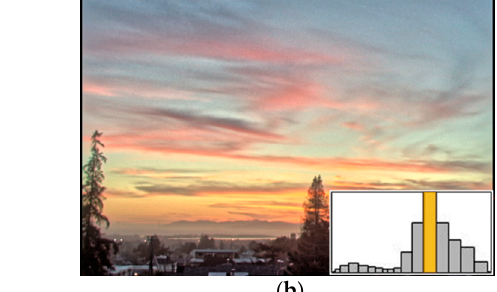
Figure 6. Self-evaluation of the proposed HVS-based modified histogram equalization. ( a ) Result and the histogram before correction, whose bin width is calculated by Equation (15). ( b ) Result and the histogram after correction, whose bin width is calculated by Equation (18). The histograms of ( a ) are too wide so that the resulting image is slightly noisy in the sky.